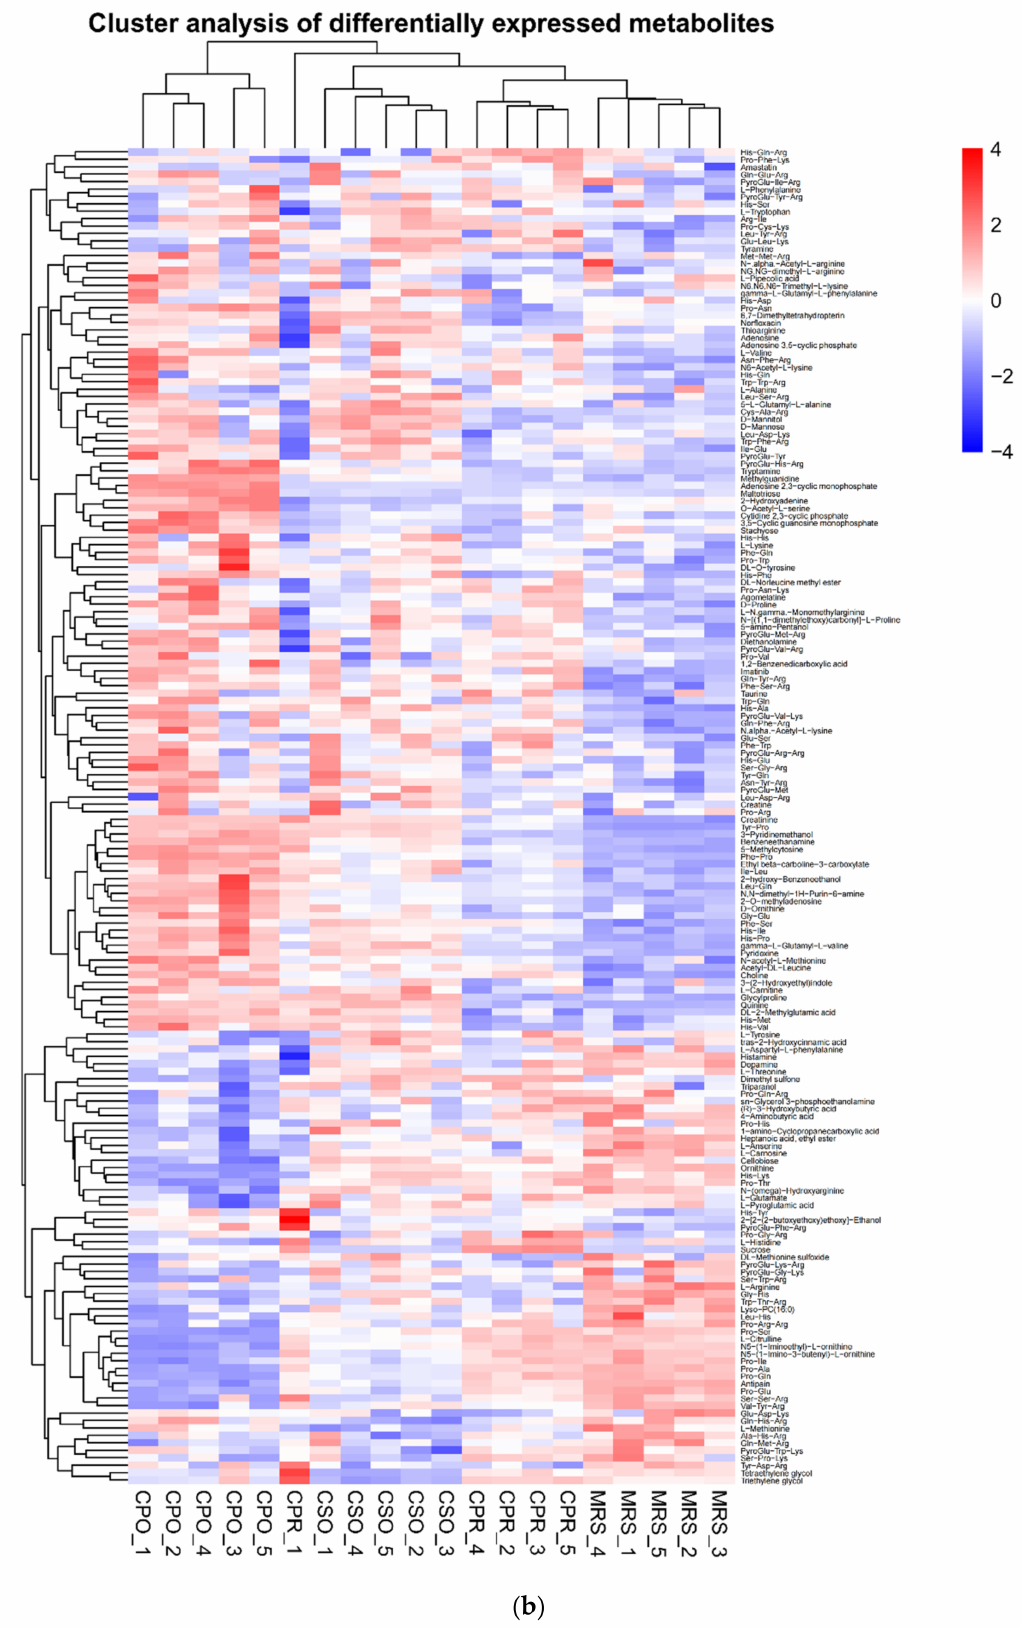
Figure 8. Heatmap of hierarchical clustering analysis of differential metabolites of L. reuteri in the medium supplemented with CSE. ( a ) Negative ion mode, ( b ) Positive ion